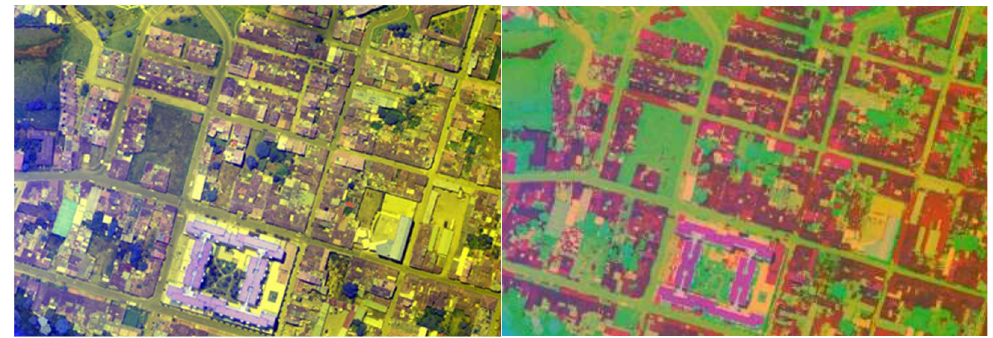
Figure 8. Data fusion imagery. RGDSM (left), RVARIB (right). Different sizes for tessellations can be used, for instance, 256 × 256, 512 × 512, and 1024 × 1024 pixels. The images and corresponding masks are then paired into single images (img, msk) with sizes of 512 × 256, 1024 × 512, and 2048 × 1024 pixels, respectively. Every (img, msk) pair is checked to pass an imbalance threshold chosen by the user, for